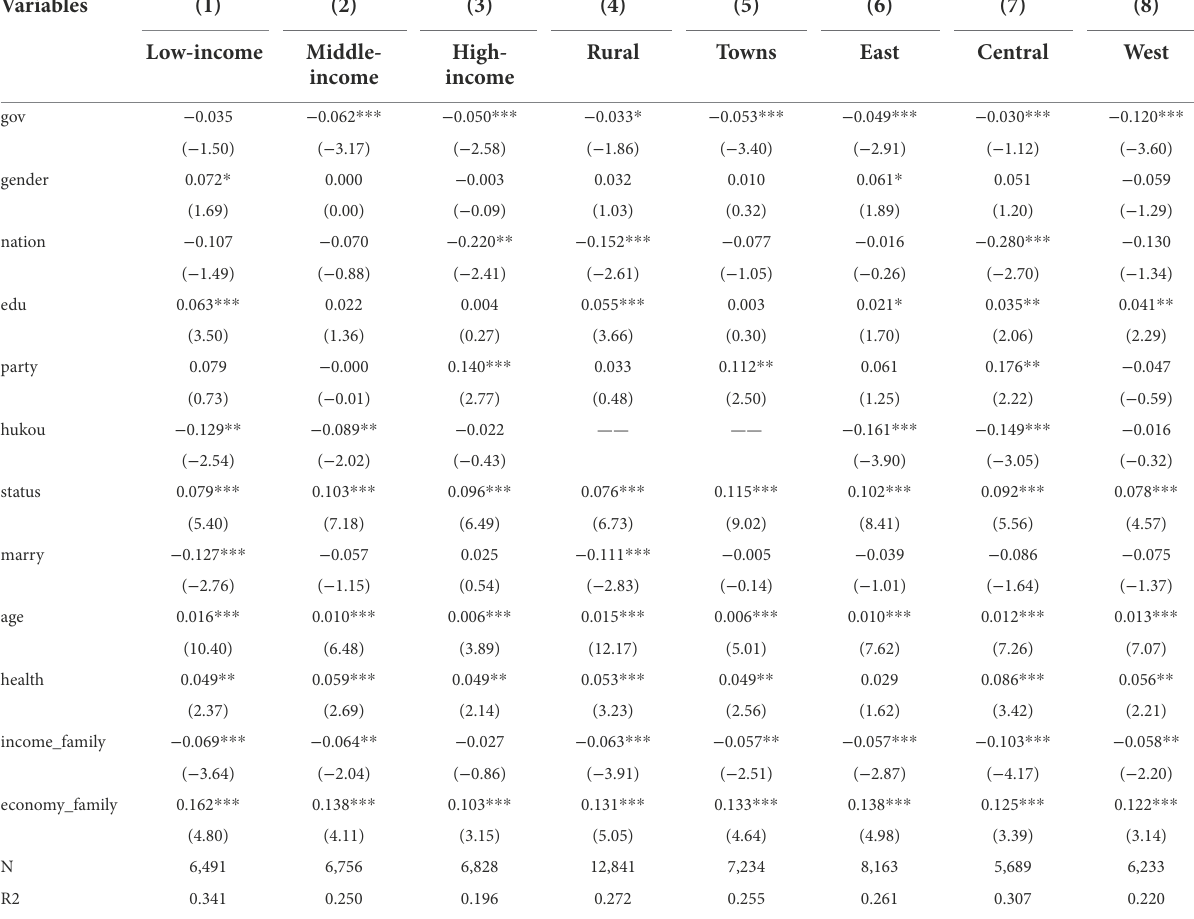
TABLE 6 Heterogeneity test results of the effect of local government competition on the perception of social fairness.